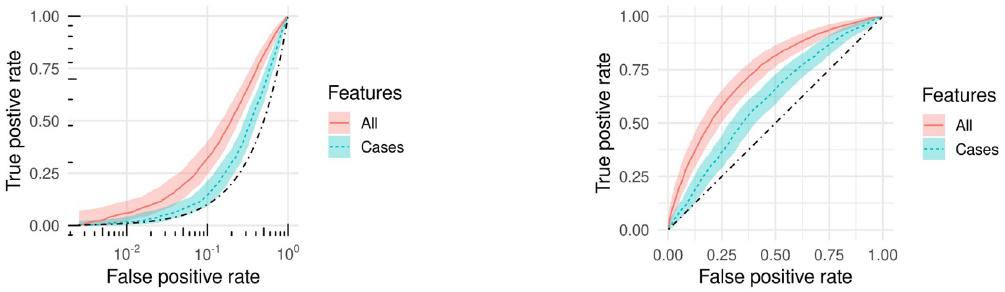
Fig 5. ROC curves of model predicting the emergence of a novel variant. The dotted black line indicates random performance. ( a ) Log scale. ( b ) Linear scale.